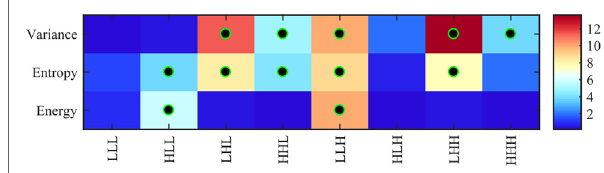
FigUre 5 | Heatmap of ANOVA test p- values ( − log 10 scale) using 24 features (8 variance, 8 entropy, and 8 energy) derived from 3D-wavelet transform bands (LLL, HLL, LHL, HHL, LLH, HLH, LHH, and HHH) comparing the four groups of lesions (stroma, benign hyperplasia, intraepithelial neoplasia, and carcinoma). Features leading to groups with significantly different texture profiles (i.e., corrected p < 0.01) are indicated with a black–green circle.